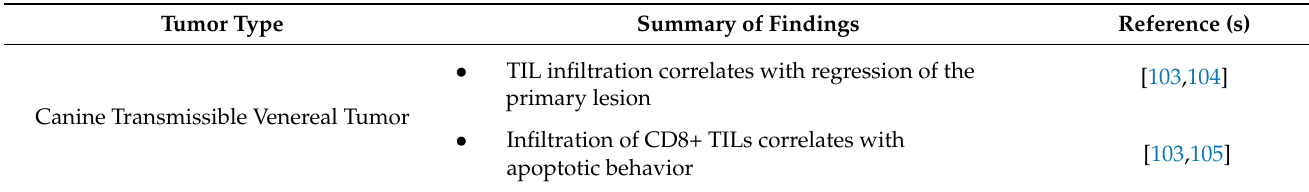
Table 1. Summary of recent findings of TIL studies in veterinary